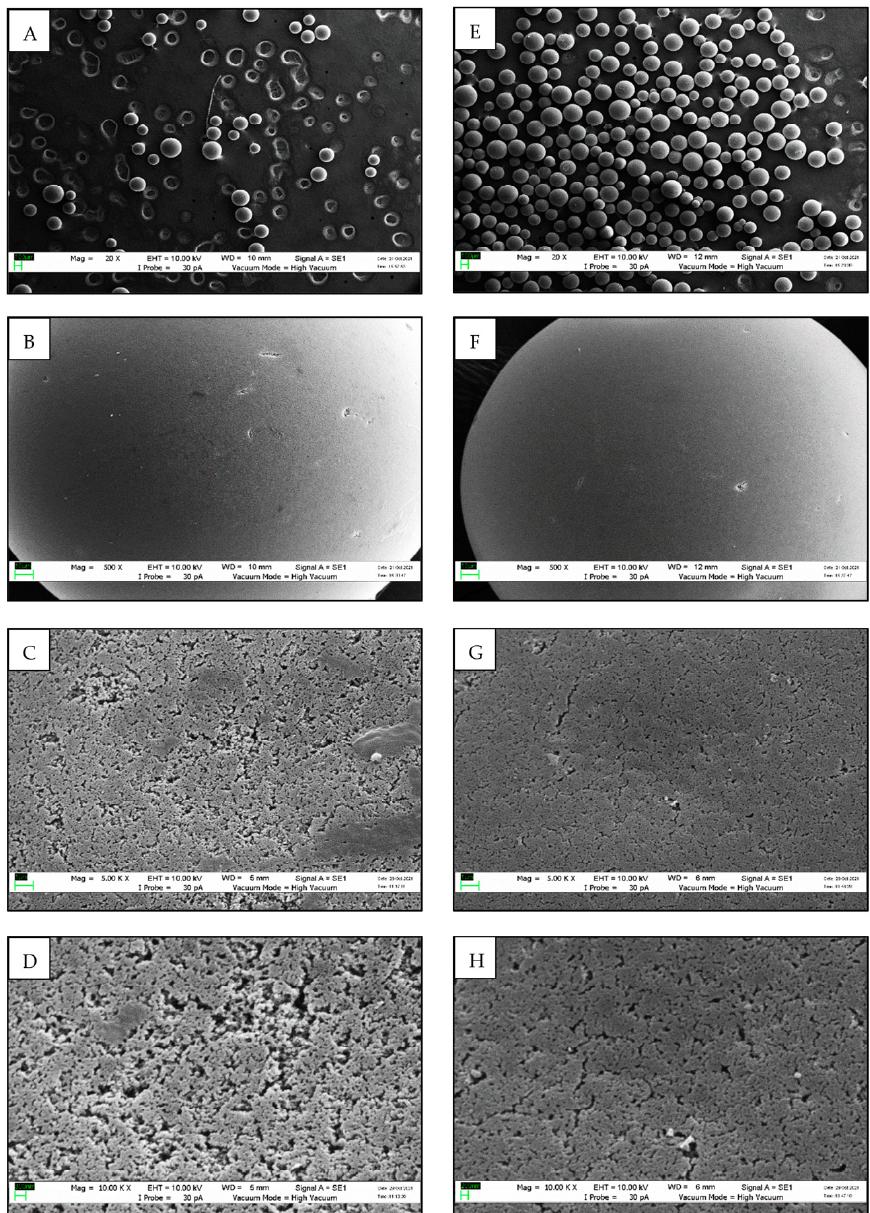
Figure 6. Scanning Electron Microscopy (SEM) images of empty Seplite LX120 and immobilized carboxylic acid reductase from Mycobacterium phlei ( Mp CAR) at 20 × , 500 × , 5000 × , and 10,000 × magnifications. Images ( A – D ) refer to empty Seplite LX120. Images ( E – H ) refer to immobilized Mp CAR on Seplite LX120.